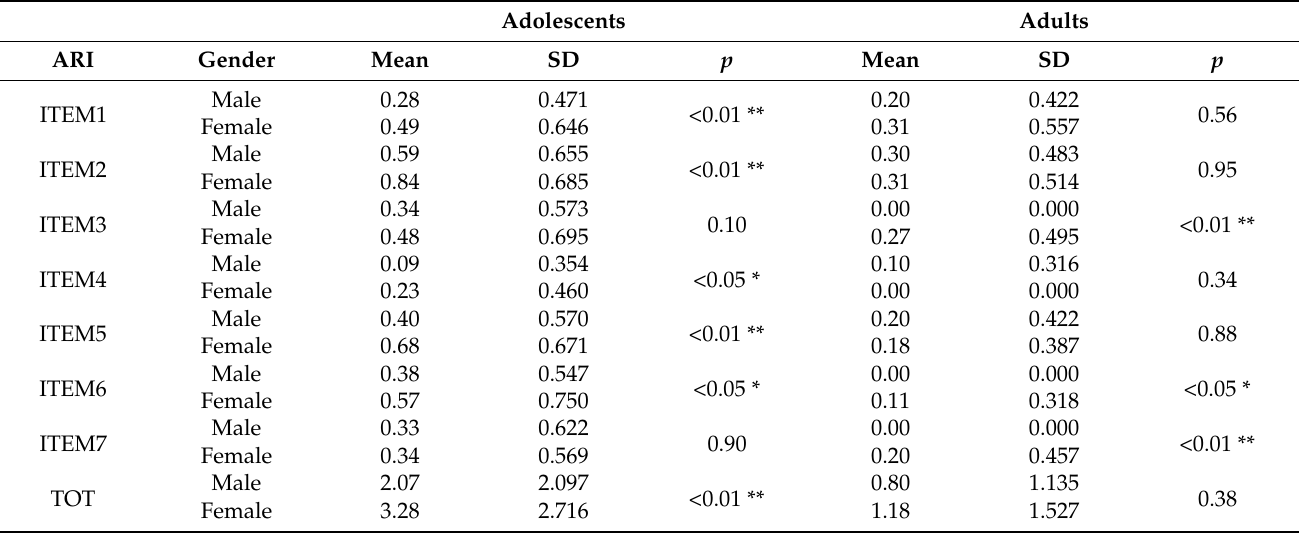
Table 7. Gender differences in ARI